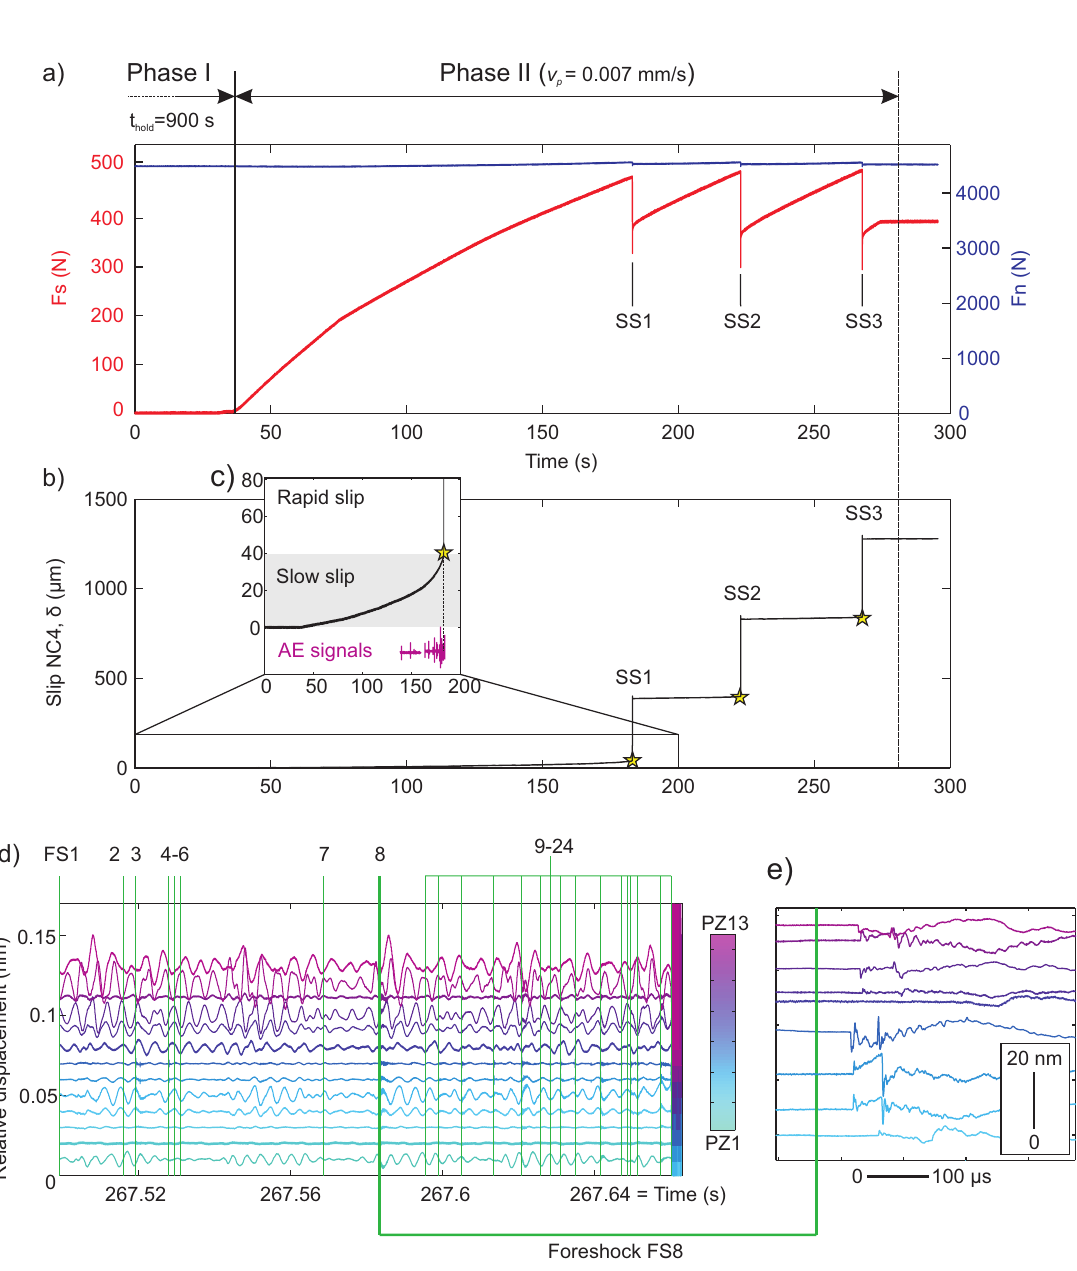
Figure 10. ( a ) Normal (blue) and shear (red) loads applied to the slider block during